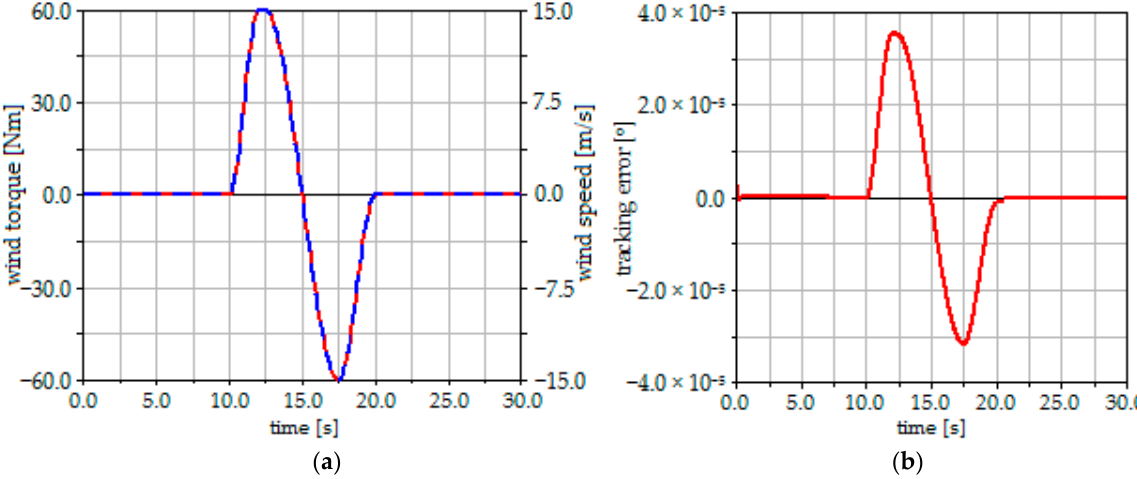
Figure 11. Verifying the control system robustness: ( a ) Torque generated by the wind action; ( b ) Tracking error.